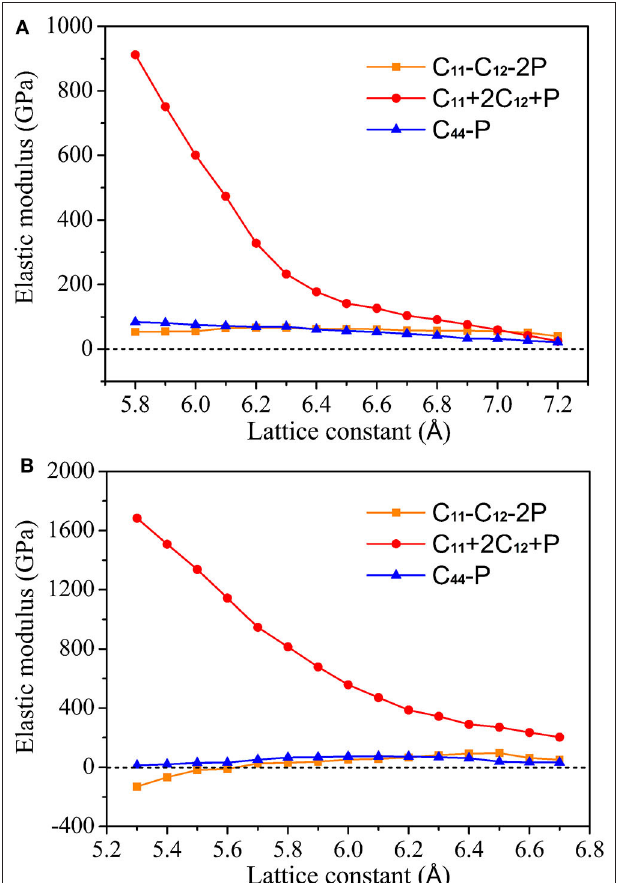
FIGURE 2 | Elastic modulus of CoCrScSn compound under different lattice constant. (A) GGA, (B) GGA + U.